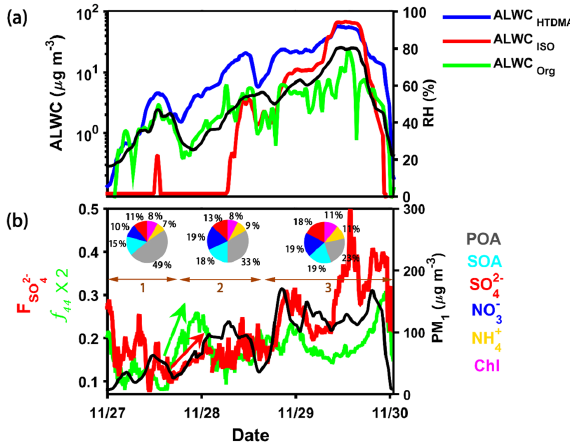
Figure 8. Time series of (a) ALWC HTDMA (in blue), ALWC ISO (in red), ALWC Org (in green) and RH (right y axis) and (b) the sulfur oxidation ratio (F 2 − ), f 44 and PM 1 mass concentration (right y SO 4 axis) during the P4 case in Fig. 2. The pie charts in (b) represent the average chemical compositions of PM 1 during three stages of the pollution event (denoted by brown horizontal lines). The red and green arrows in (b) indicate the rapid increase in F and f 44 at SO 42 − the initial stage. The date in this figure is in the mm/dd